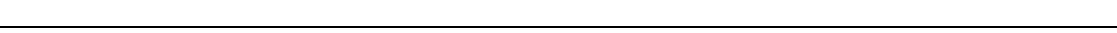
Fig. 1 Experimental protocol and generation of brain network. a Schematic representation of the imaging planes (blue). The hippocampus (HC) is highlighted in gray. Numbers indicate z coordinate in mm from bregma. b Representative evoked population spike (PS) in the dentate gyrus before (black) and after (red) LTP induction. c Representative fMRI maps across the HC during perforant path stimulation overlaid on an anatomical T2-weighted image with atlas parcellations (see Supplementary Note 2). Color indicates signi fi cant correlation ( p < 0.005 corrected). d Time course of the experiment. Input/ output (I/O) response curves are recorded in the local- fi eld potentials (LFP). fMRI signals are collected during low-frequency (10 Hz) test stimulations before and 3 h after LTP induction. e Field excitatory postsynaptic potential (EPSP) slope and, f population spike (PS) amplitude before (black) and after (red) LTP. Two-way repeated measures ANOVA ( n = 5, α = 0.05) reveals signi fi cant effects of LTP in both measures ( F 1,24 = 27.82, p < 0.0001, and F = 59.89; p < 0.0001 for PS and EPSP, respectively). Mean ± SEM. Post-hoc Bonferroni: * p < 0.1; ** p < 0.01; *** p < 0.001; **** p < 0.0001 1,24 g Representative fMRI maps in one animal after LTP induction. Color code as in ( c) ( p < 0:005; see Supplementary Note Fig. 1 for group activation maps and Supplementary Note 2 for details). Size bar corresponds to 0.5 mm. h , i Number of active voxels per selected region in control (black) and LTP (red) conditions in hippocampal ( h ) and extra-hippocampal areas ( i ). The stimulated region is the ipsilateral hippocampus (iHC); two-way repeated-measures ANOVA ( n = 7, α = 0.05) reveals signi fi cant effects for LTP in hippocampal ( F 1,12 = 15.72, ## p = 0.0019) and extrahippocampal regions ( F 1,12 = 7.426, # p = 0.0184), with no interaction between regions ( F = 0.00242, p = 0.9616 and F = 1.518, p = 0.2415 for hippocampal and extra-hippocampal 1,12 1,12 regions, respectively). Mean± SEM. j Brain network formed by the HC, NAc, and PFC for the animal in ( g ). The brain network is formed by intra-network interactions and inter-network interactions inferred from fMRI correlation data (Supplementary Note